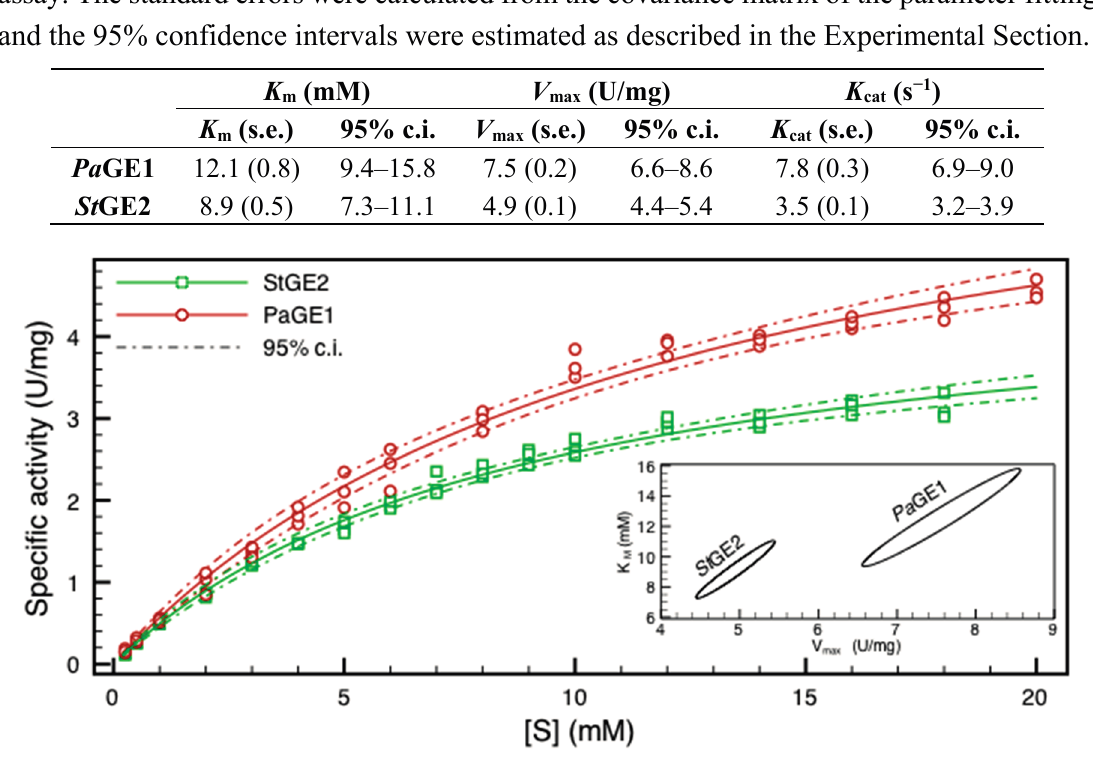
Figure 2. A least-squares regression fit of the Michaelis-Menten equation to the assay rate data for Pa GE1 and St GE2. The dashed lines in the main graph and the inset contour plot present two different views of the 95% confidence intervals of the parameter